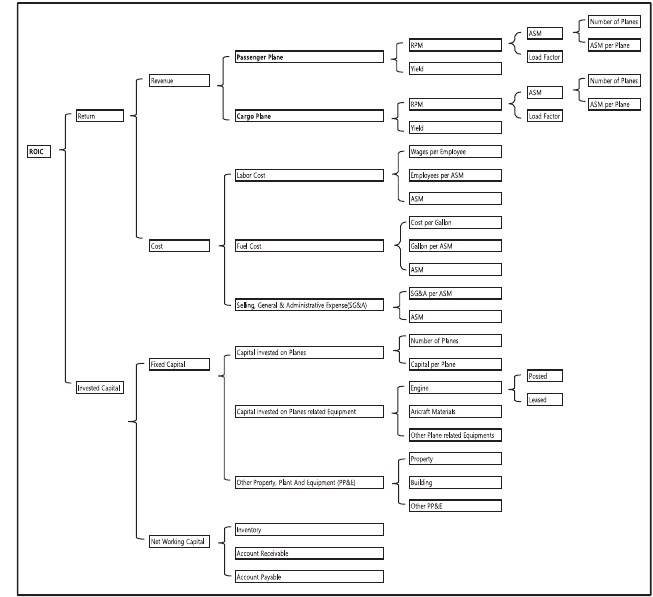
Fig. 1. ROIC tree model expansion for Airline Industry developed for this